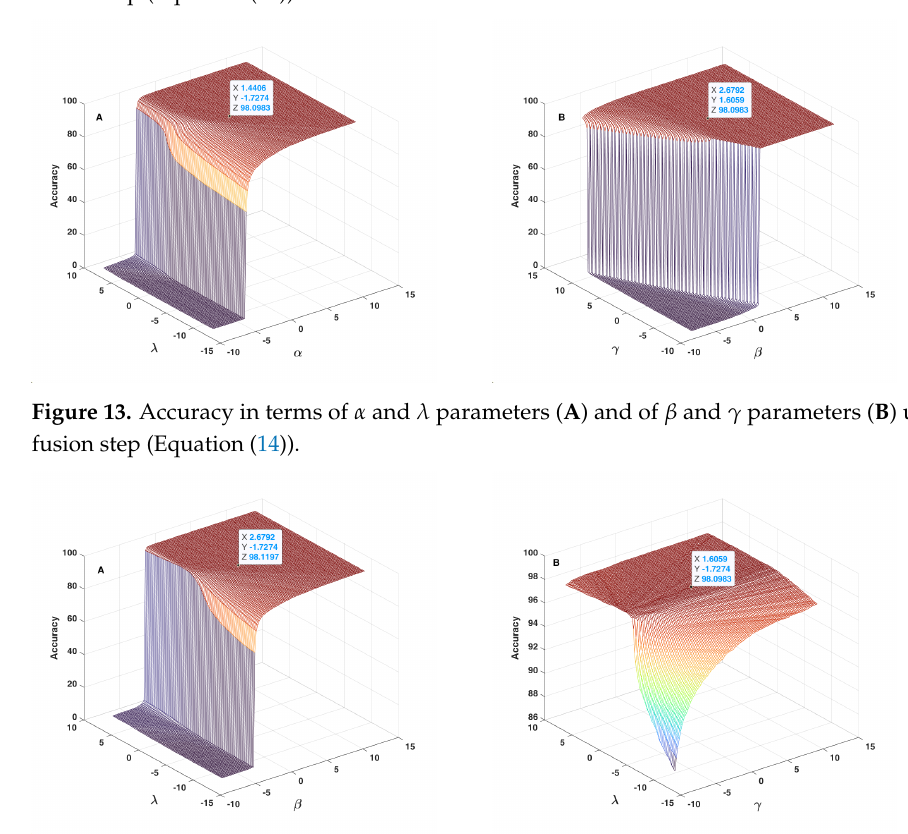
Figure 14. Accuracy in terms of β and λ parameters ( A ) and of λ and γ parameters ( B ) used in the fusion step (Equation